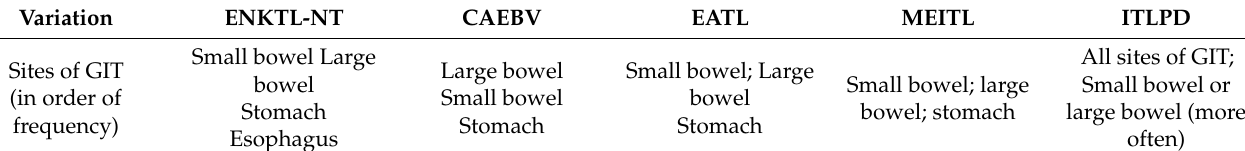
Table 1. Lymphoproliferative disorders of T/NK-cell origin with GIT